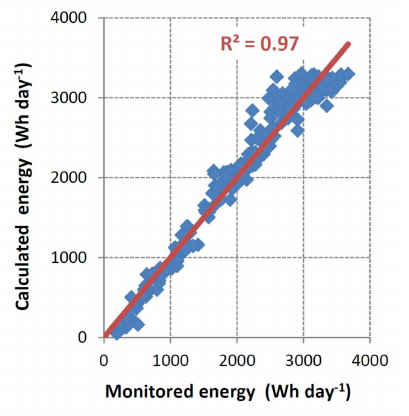
Figure 2. Adjustment of the proposed model for the estimation of the energy